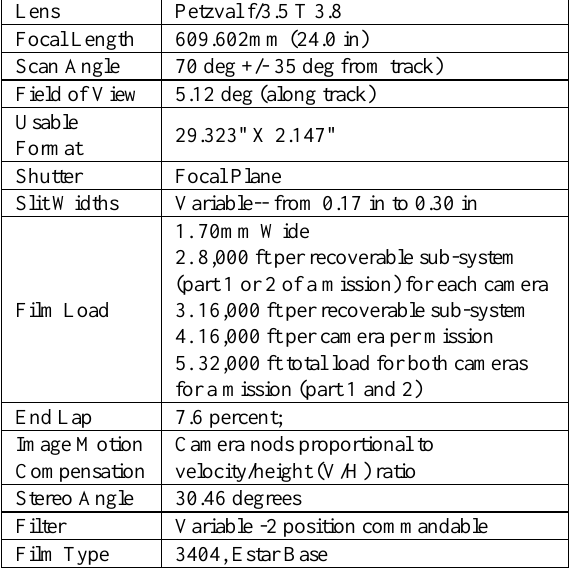
Figure 5. Small portion of Corona image depicting study area The polynomial coefficients are then used to transform non- control points. The simplest transformation in this scheme is an affine transformation (Schenk, T. et al, 2003) .